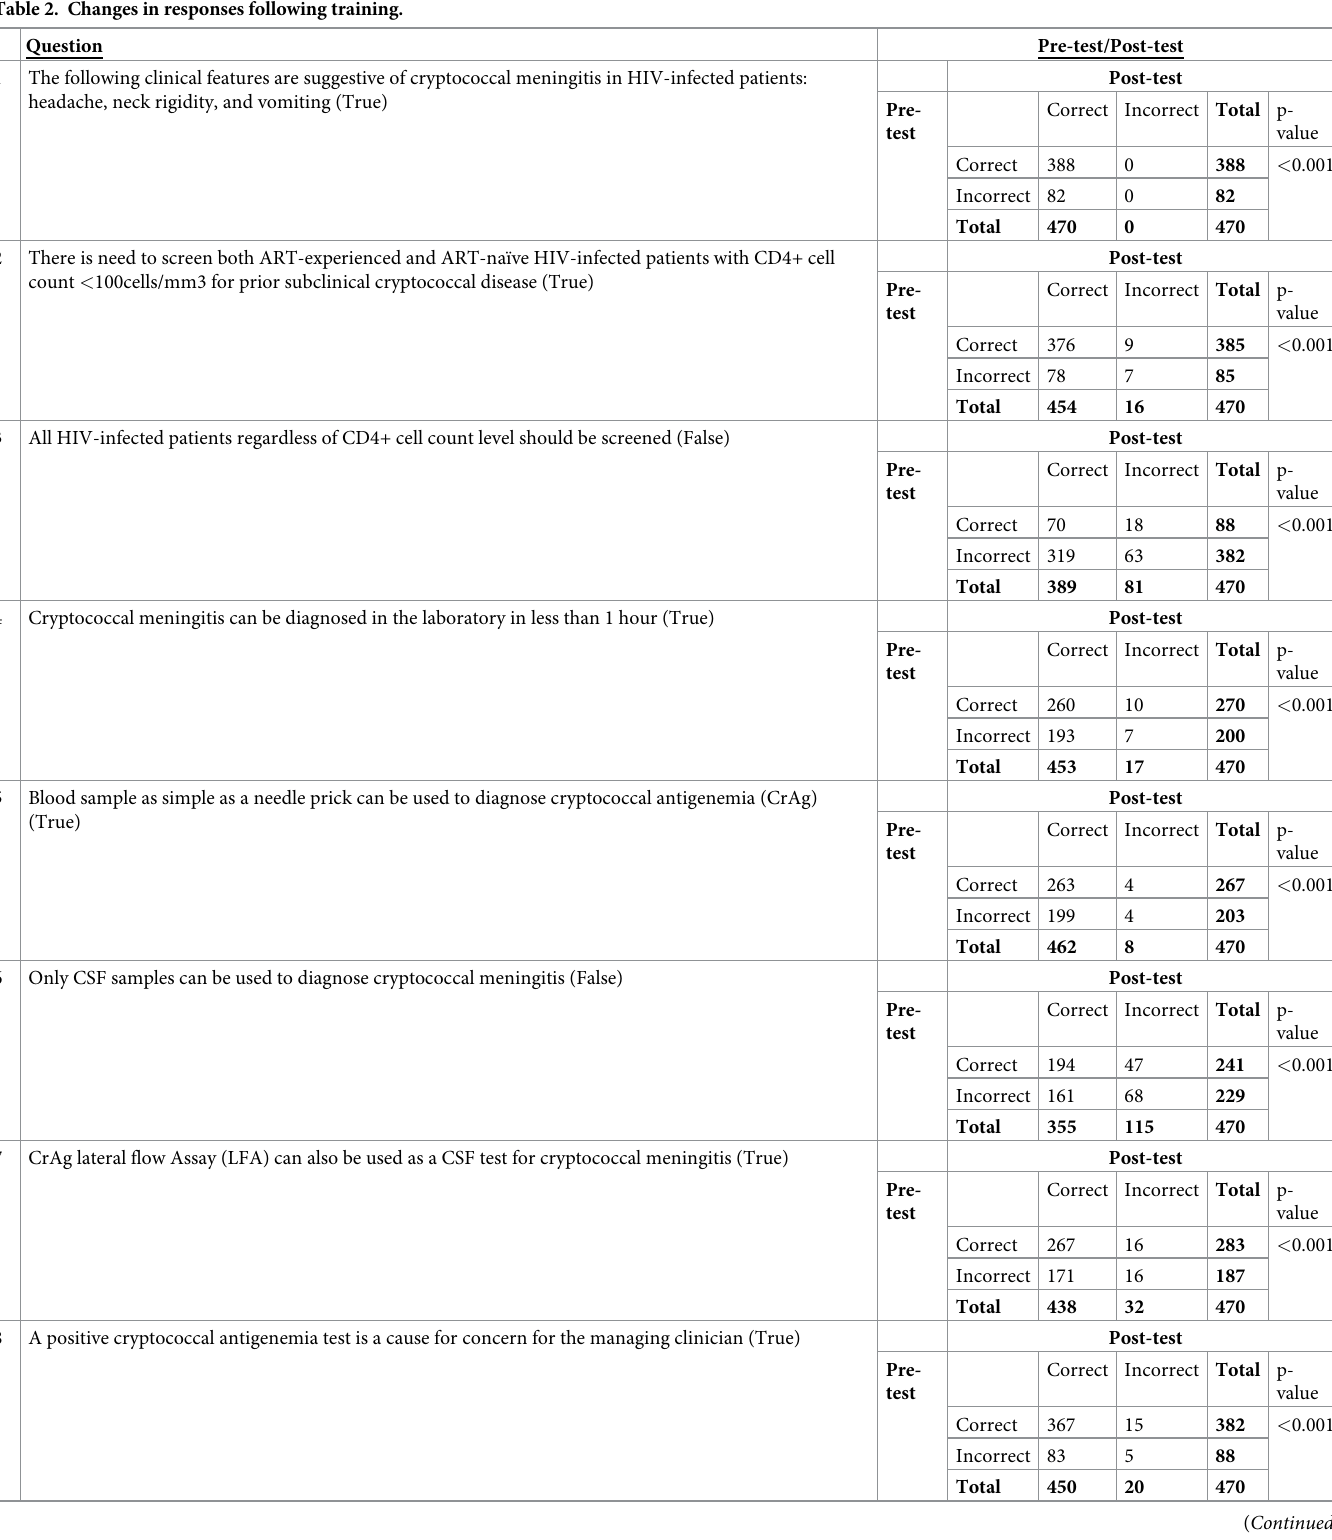
Table 2. Changes in responses following